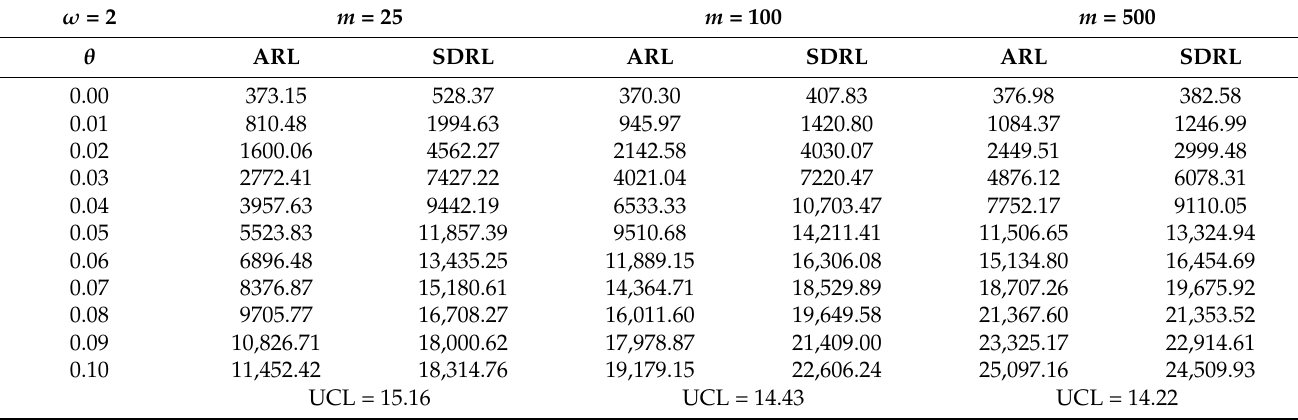
Table 4. ALR 0 and SDRL 0 values of the multivariate Shewhart control chart with outliers ( ω =